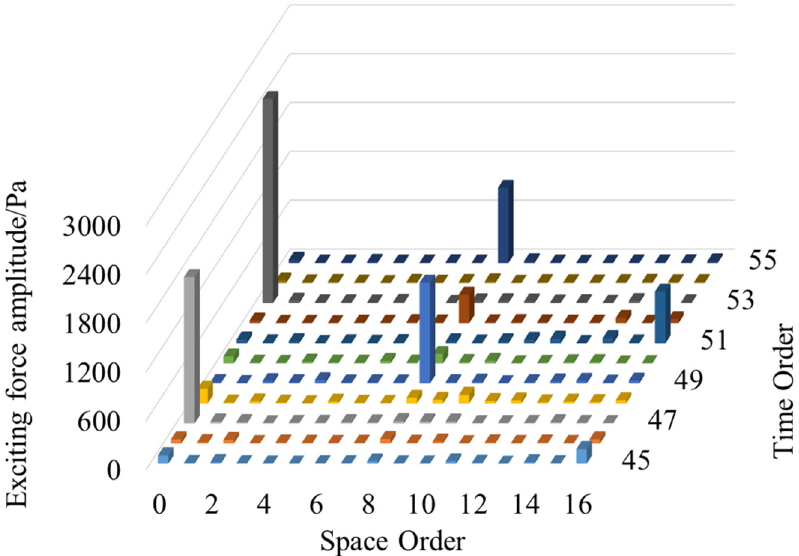
Figure 7. Two-dimensional Fourier decomposition results of the excitation force of the straight slot motors at 3000 rpm .